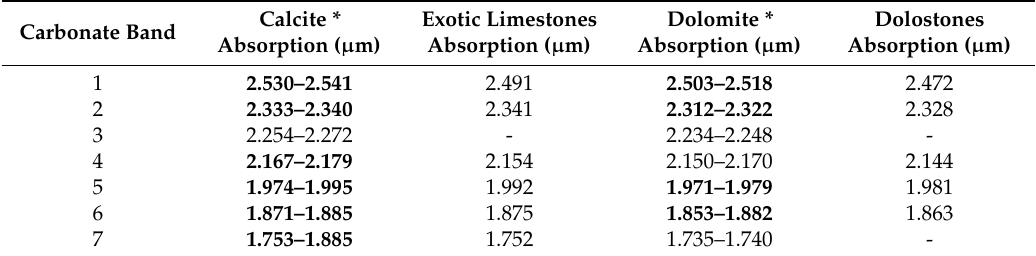
Table 2. Spectral absorption positions of calcite and dolomite minerals [33] and exotic limestones and dolostones in the SWIR